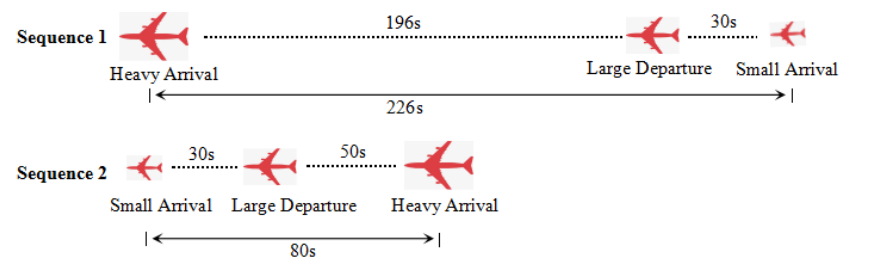
Figure 1. The runway occupation time reduces 65% for the same three aircraft after